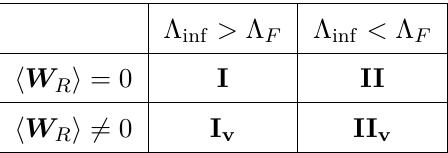
Table 1 . Different scenarios of SU(2) R -axion inflation. Based on the scale of inflation Λ inf = √ M H , scale of left-right symmetry breaking Λ F , and the (possible) SU(2) R field’s VEV in infla- Pl tion, one can separate four different types of